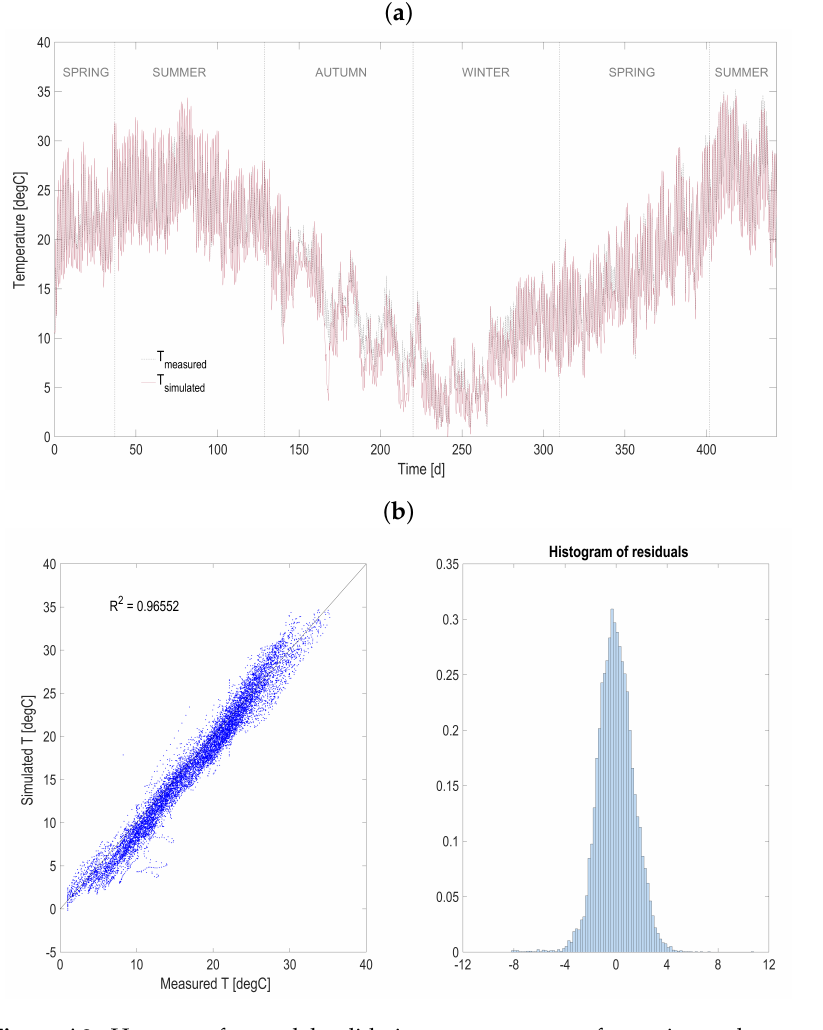
Figure A2. Heat transfer model validation over one year of experimental measurements for the HRABP located in Narbonne (F). ( a ) measured and simulated temperature. ( b ) correlation with measurements and distribution of error